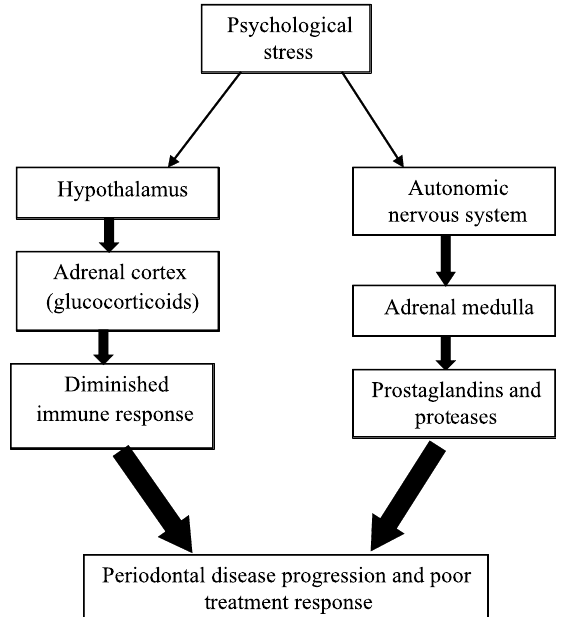
Fig. 2. Mechanisms linking maladaptive stress coping and progression of periodontal diseases and/or poor response to treatments